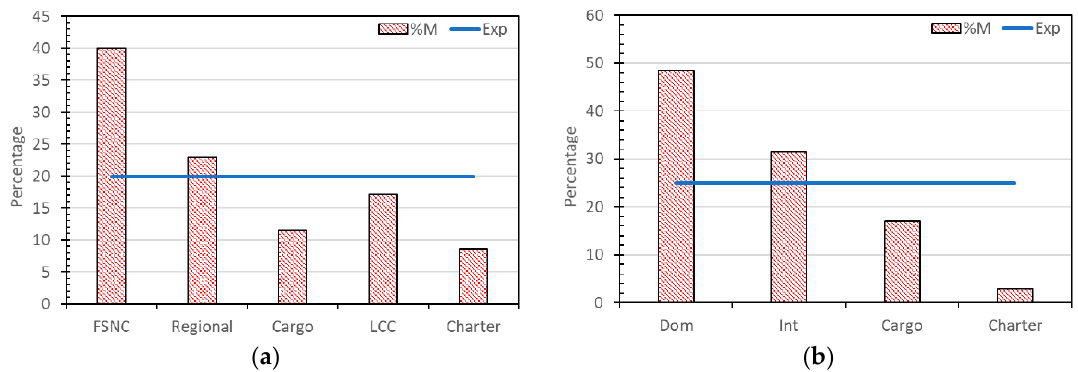
Figure 9. Results for aviation aspect of the accidents with maintenance contributions: ( a ) the operators business model; ( b ) the type of operation/service.